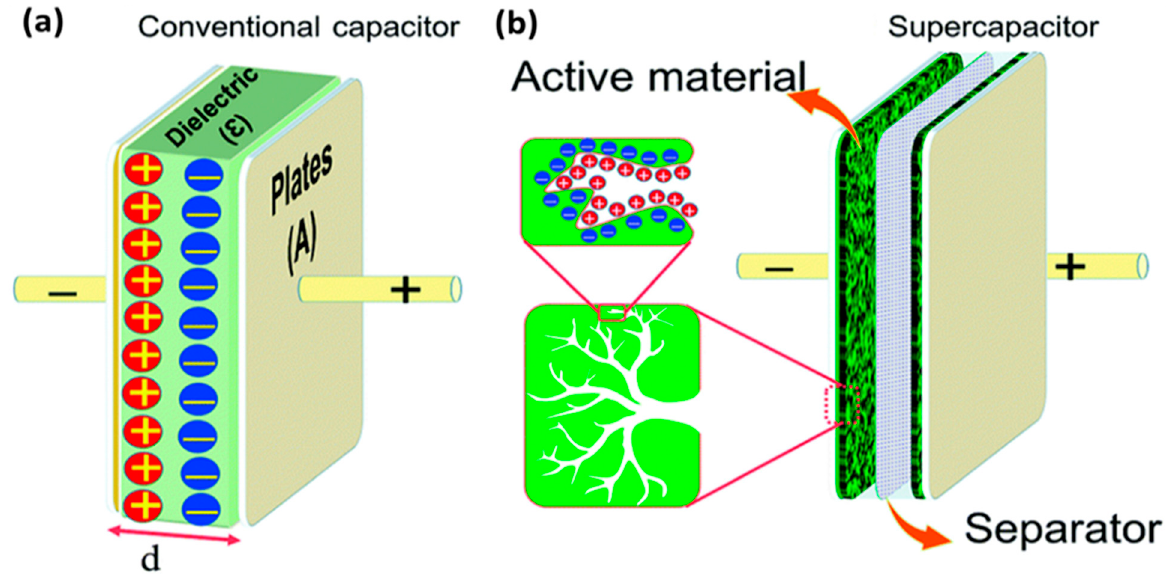
Figure 19. A schematic representation of ( a ) a conventional capacitor and ( b ) a supercapacitor along with the electrical double layer formation. Reprinted with permission from Ref. [157].